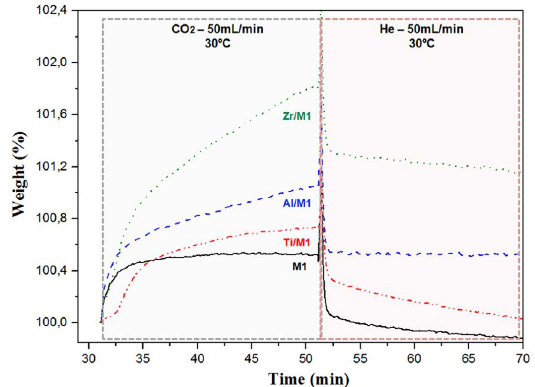
adsorption cycles of samples M1 before and after Figure 7. CO 2 the incorporation of heteroatoms (Al, Ti and Zr). Figure 8. FTIR spectra of PEHA-functionalized